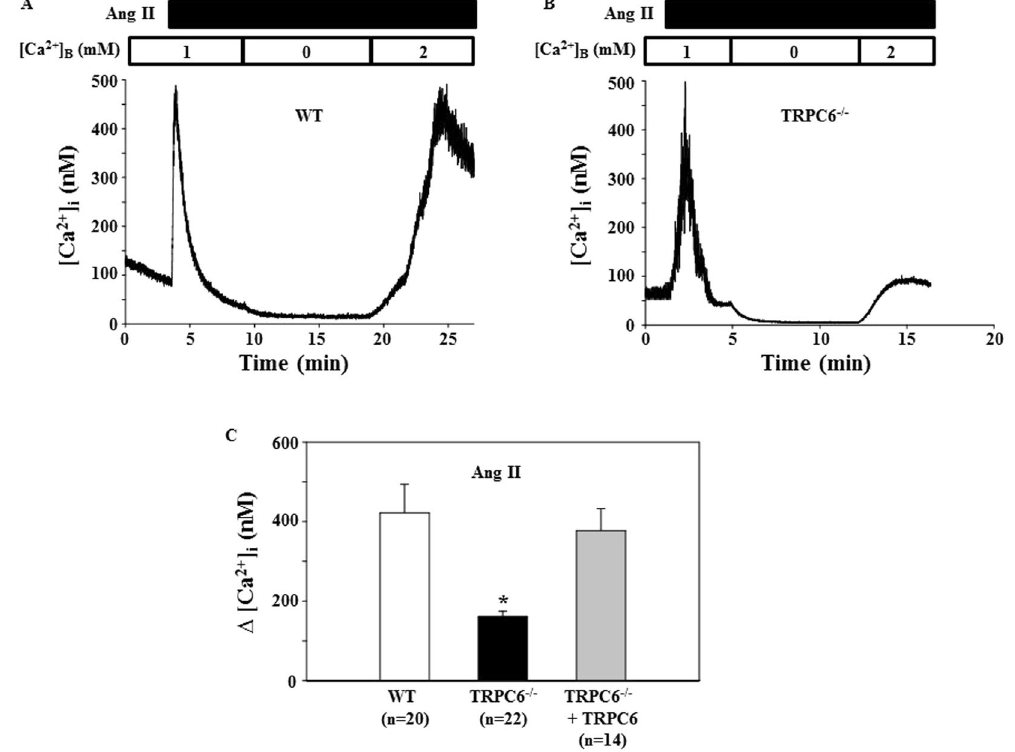
Figure 7. Ang II-induced Ca 2 + response in primary mouse MCs. ( A and B ) Representative traces, showing [Ca 2 + ] i in response to 1 μ M Ang II in the MC isolated from a WT ( A ) and TRPC6 − / − ( B ) mouse. [Ca 2 + ] B indicates the Ca 2 + concentration in bathing solution. Application of Ang II is indicated by a horizontal bar at the top. ( C ) Summarized Ca 2 + entry response to 1 μ M Ang II in WT, TRPC6 − / − mouse MCs, and TRPC6 − / − mouse MCs introduced with rat trpc6 . Δ [Ca 2 + ] i was calculated by subtracting [Ca 2 + ] i before re-addition of 2 mM Ca 2 + to the bath from the peak [Ca 2 + ] i after re-addition. The numbers inside the parentheses represent the number of cells analyzed from 6 WT and 6 KO mice. * P < 0.05, compared to both WT and TRPC6 − / − +